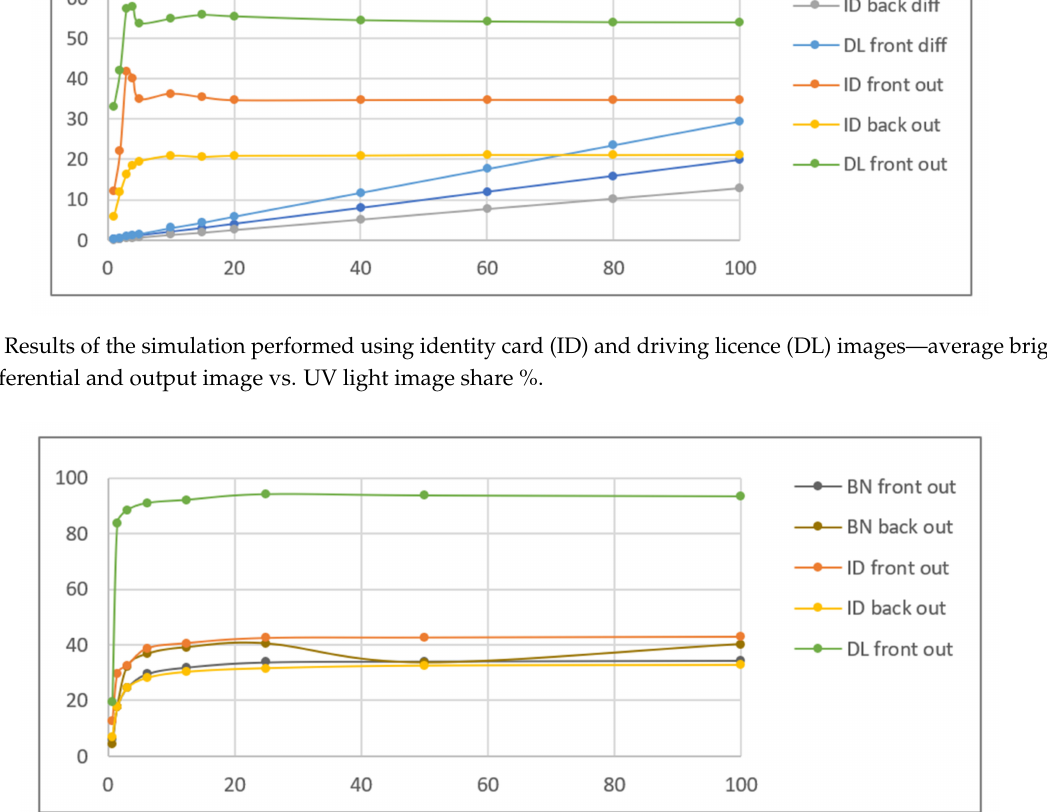
Figure 7. Results of the simplified simulation performed with banknote (BN), identity card (ID), and driving licence (DL) images—average brightness of the output image vs. relative brightness of the dark UV light image % (data regarding differential images has been omitted for clarity).